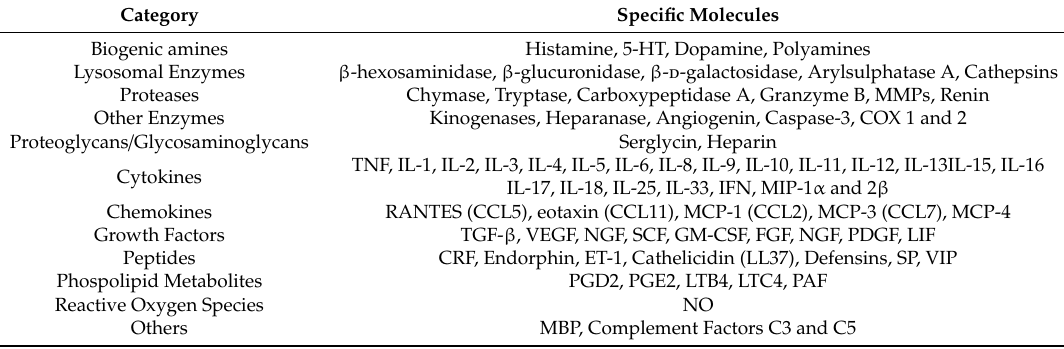
Table 1. Molecules that may be secreted by mast cells a